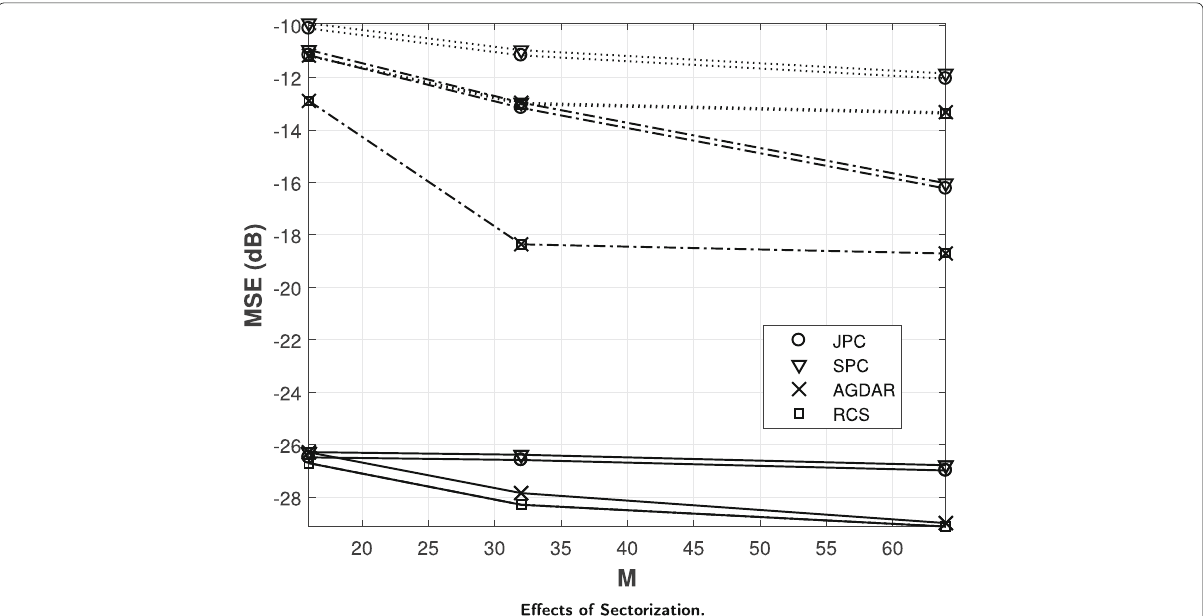
Fig. 9 Effects of sectorization. MSE vs M = M 1 = M 2 for ULAs and various channel estimation techniques, when the average SNR is 10 dB when sectorization is used, with 6 (solid lines), 60 (dashed lines), and 180 ◦ (dotted lines). N r = N t =